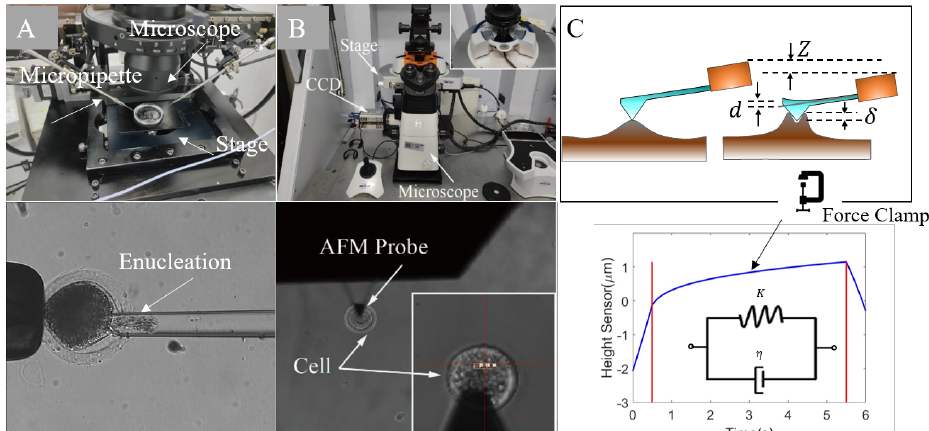
Figure 1. The AFM measurements. ( A ) An in-house robotic platform (upper image) designed for cell micromanipulation (injection, rotation, enucleation, etc.) was employed to isolate the ZP and cytoplasm from an oocyte. It integrated an inverted microscope, a pair of customly designed X-Y-Z micromanipulator, X-Y stage, micropipette holders, a CCD camera, a pressure controller, etc. We maneuvered the micropipette to aspirate out cytoplasm (enucleation, bottom image) and leave the ZP debris. Both the cytoplasm ball and the ZP debris were immediately transferred to the polylysine- coated slide for measurement. ( B ) Bruker Bioscope Resolve AFM (upper image) integrating baseplate, CCD camera, inverted optical microscope, probe holder, SPM head and EasyAlign unit. During measurement, the indentation was performed on the multiple sites of an specimen, as shown in the bottom image. ( C ) The calculation of indentation from the scanner movement and cantilever deflection δ = Z − ( 1 + e ) d , e is the calibration error of the deflection sensitivity. The force was clamped for several seconds once the predefined value was reached to observe the